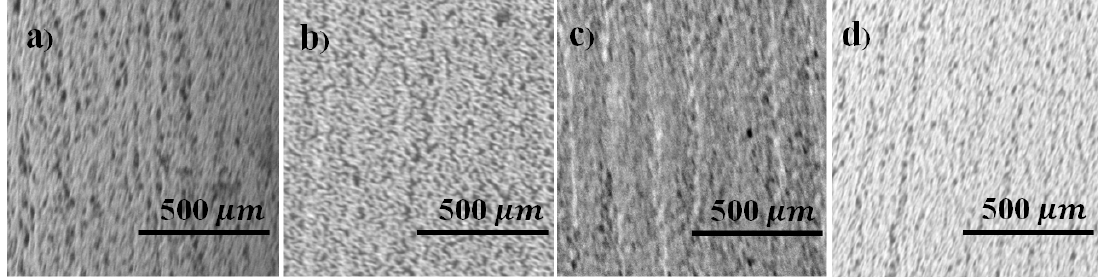
Figure 8. Surface morphology of the printed patterns sintered at 300 °C: ( a ) 1 L, ( b ) 2 L, ( c ) 3 L, ( d ) 4 L sintered at 300 °C.